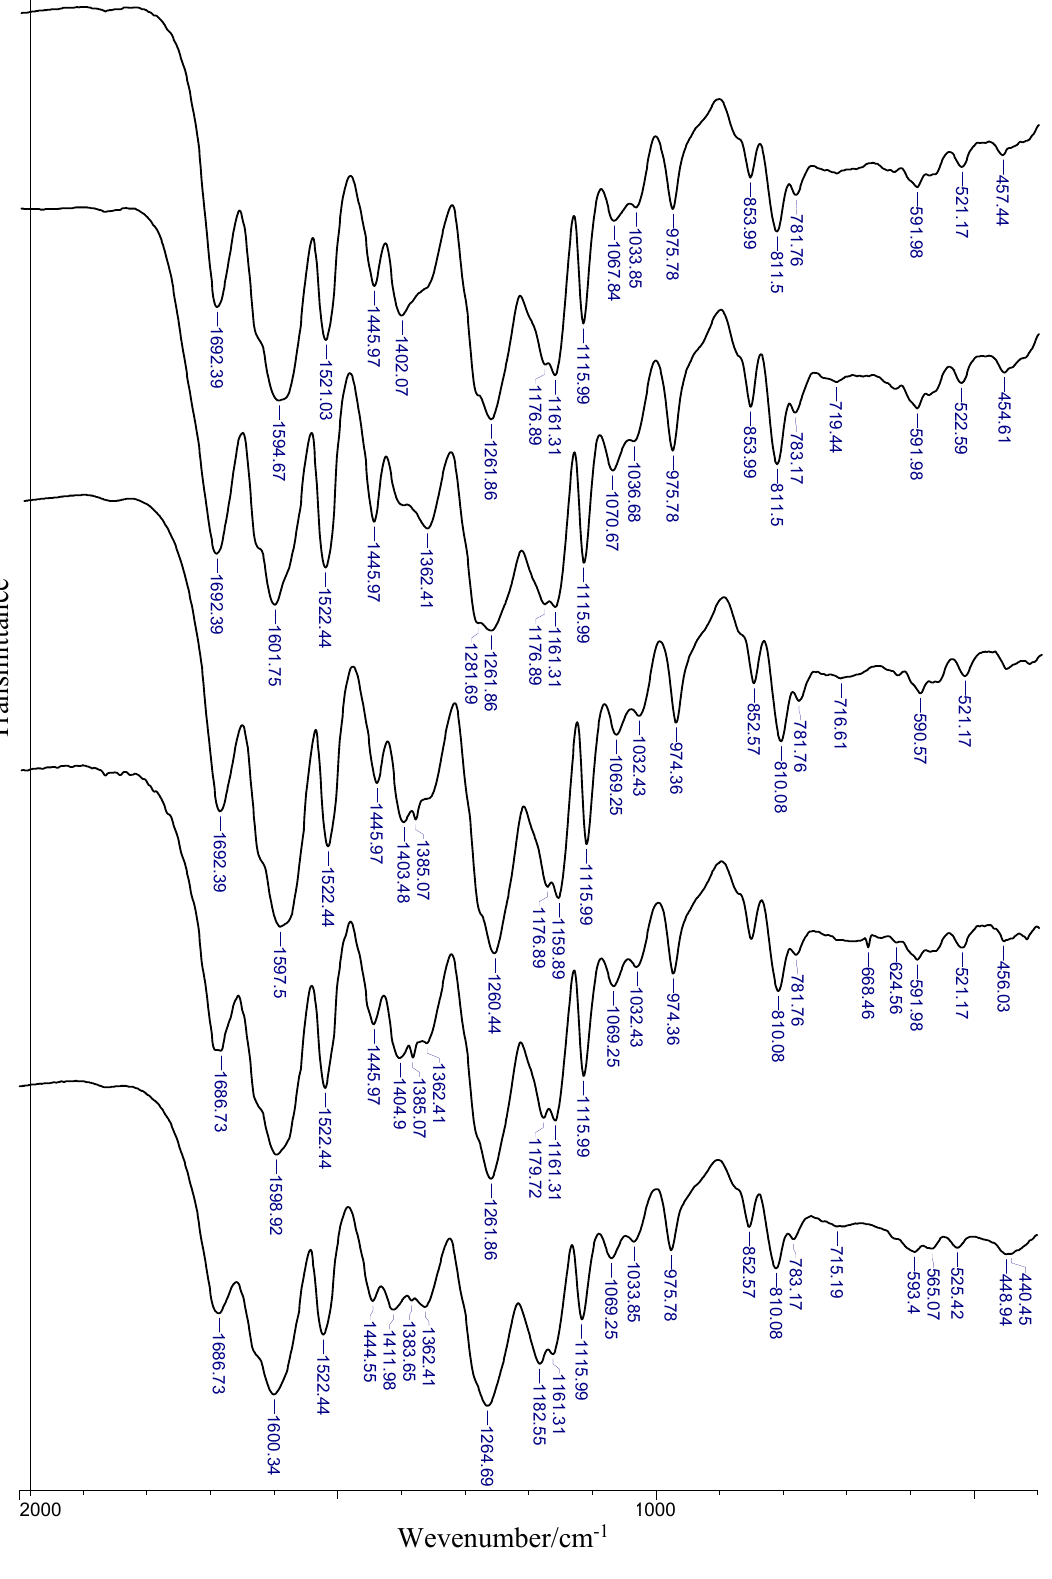
Figure 5. Experimental vibrational spectra of Li, Na, K, Rb, and Cs rosmarinates (shown from bottom to top).